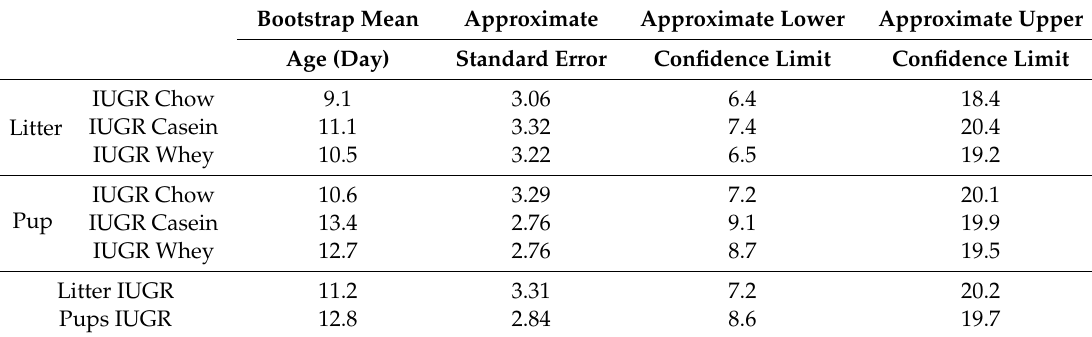
Table 2. Time of catch up growth (day of suckling period) in litters and pups. Bootstrap Mean Approximate Approximate Lower Approximate Upper Age (Day) Standard Error Confidence Limit Confidence